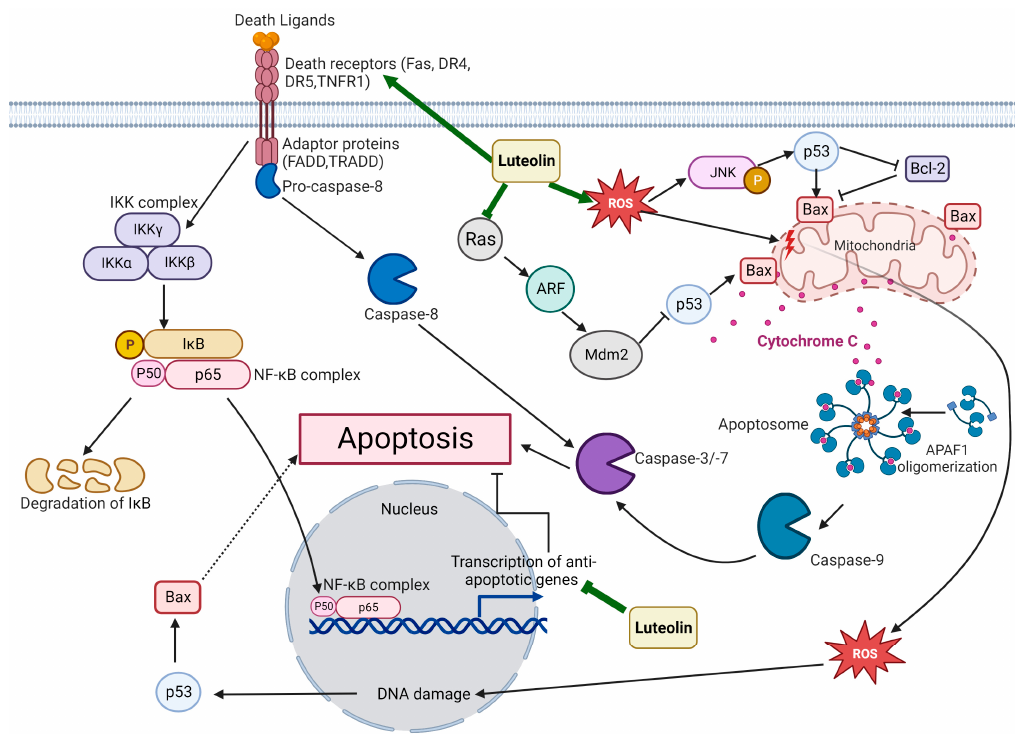
Figure 3. Summary of the possible mechanisms of apoptosis induction by Luteolin in cancer cells. Luteolin has been identified to regulate both extrinsic and intrinsic apoptotic pathways. Luteolin can trigger the extrinsic apoptosis pathway by promoting the expression of death receptors and their downstream factors, and it has been identified to suppress other death receptor signaling pathways contributing to cell survival. It can regulate the intrinsic apoptosis pathway by regulating mitochondrial membrane potential, cytochrome c release, and inhibiting the expression of antiapoptotic proteins such as Bcl-2. Additionally, Luteolin can inhibit Mdm2, which is activated by Ras, and Mdm2 expression is found to trigger the degradation of the tumor suppressor p53. p53 regulates apoptosis by promoting pro-apoptotic protein Bax expression and decreasing Bcl-2 levels. The direct regulation of apoptosis by Luteolin has been identified by modulating DNA damage that is induced by reactive oxygen species (ROS), where DNA damage signaling has been determined to promote p53 production and activity. Arrows designate activation ( ↑ ) and inhibition ( ⊥ ) of the molecules, and green arrows represent activation ( ↑ ) and inhibition ( ⊥ ) of the molecules by